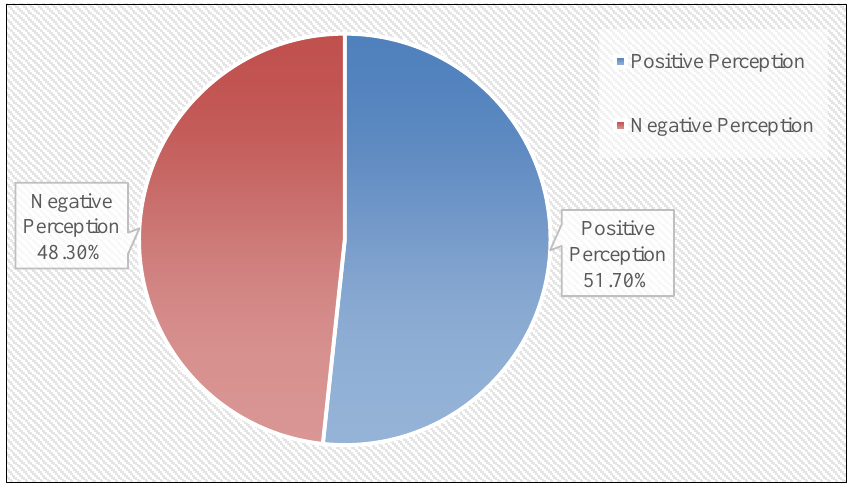
Figure 3. Patients’ perceptions life and social limitations due to CKD and dialysis therapy